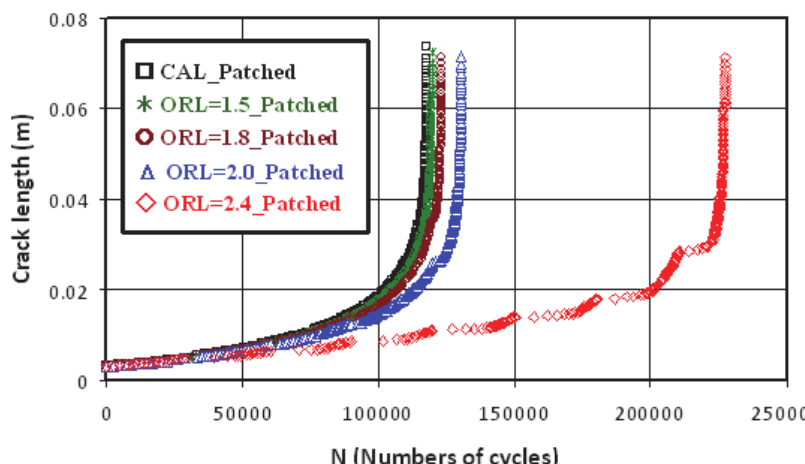
Figure 5: Overload ratio effect on fatigue life for repaired 2024 T351 Al-alloy plate.